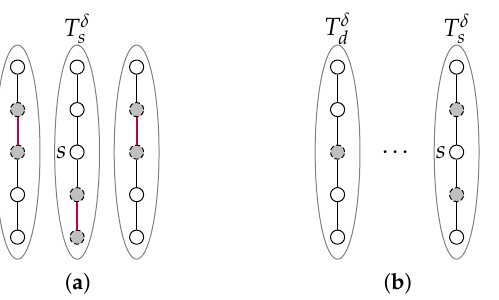
δ δ d , δ s ∪ ˜ P t d , δ s d